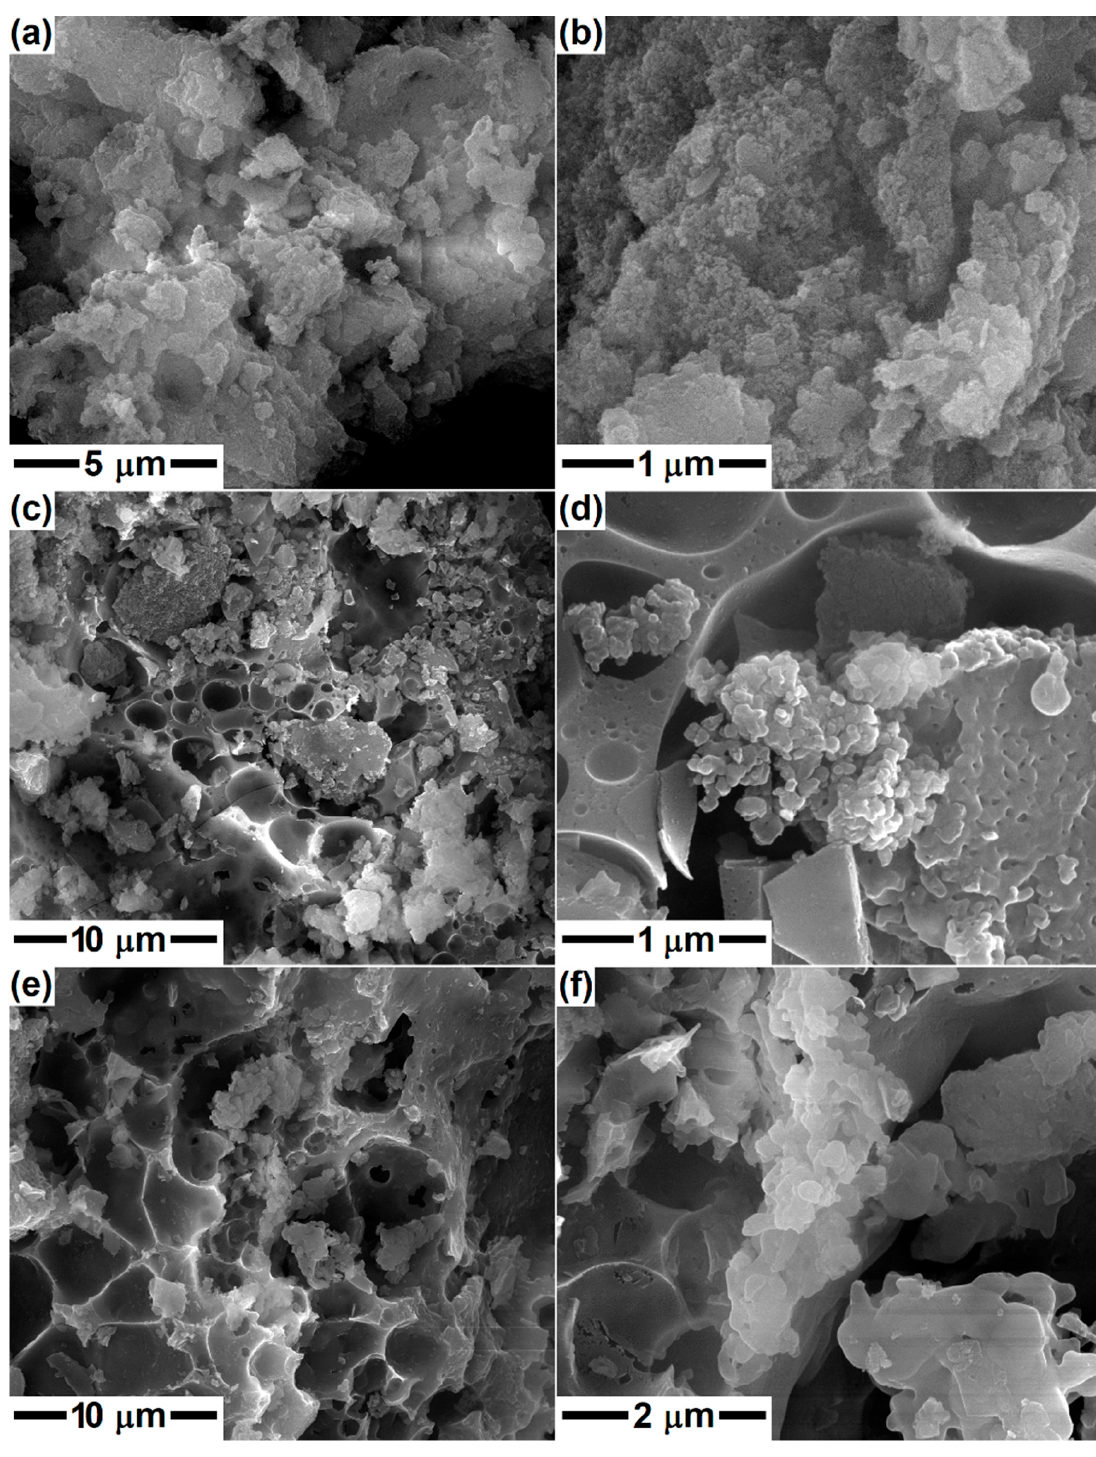
Figure 3. SEM images of the ceramics corresponding to diopside composition, thermally treated at: ( a , b ) 600 °C; ( c , d ) 800 °C; and ( e , f ) 1000 °C.